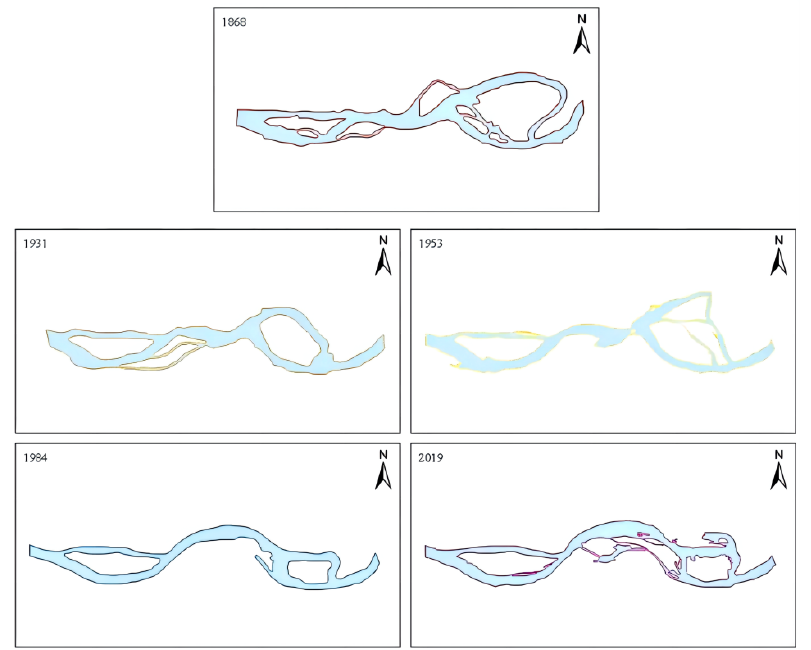
Figure 15. Changes of water areas and rivers in the upper reaches of the Yangtze River in Zhenjiang from 1868 to 2019.